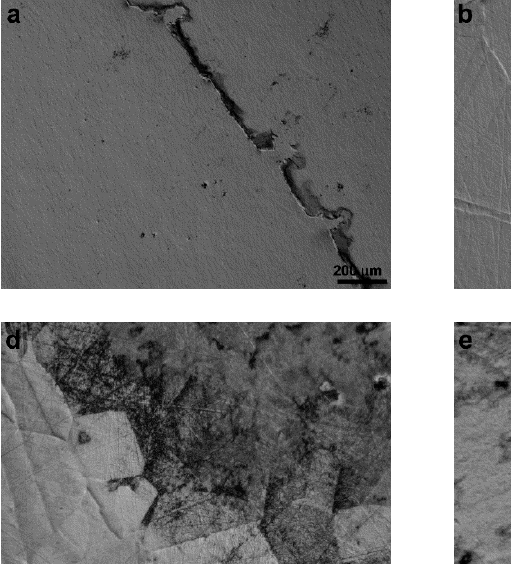
Figure 13. Surface morphology (detail) after the potentiodynamic tests of samples untreated ( a ), nitrided at 360 °C, 50 vol.% N 2 + 50 vol.% H 2 , for 1 ( b ) and 5 ( c ) h, and at 380 °C, 50 vol.% N 2 + 50 vol.% H 2 , for 3 h ( d ).